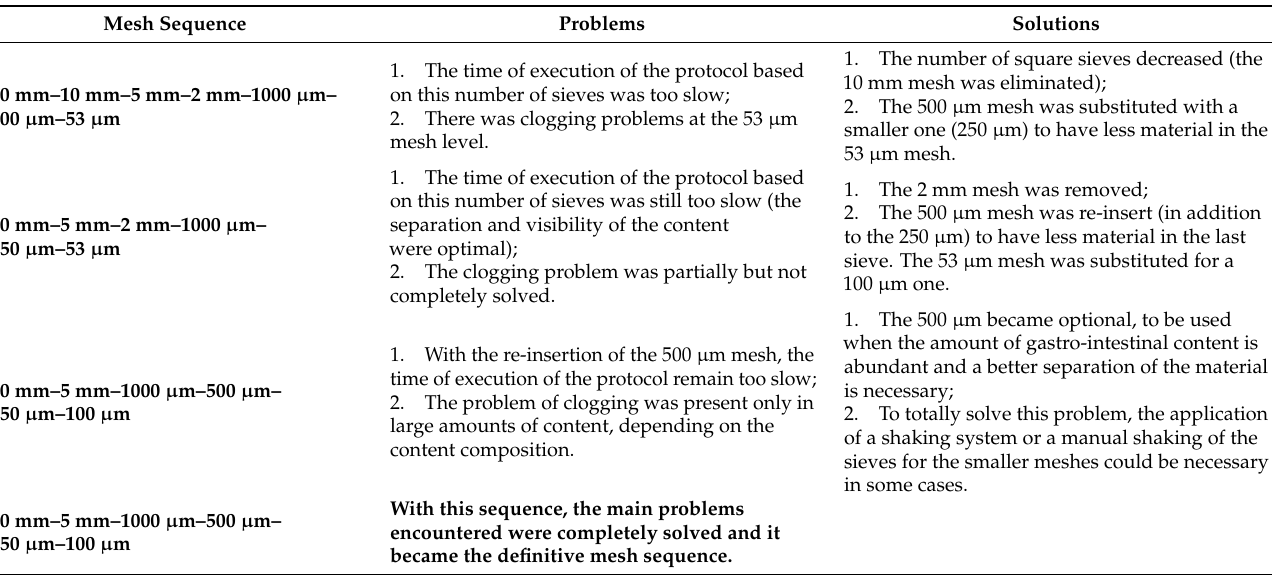
Table 3. Meshes size selection process. Mesh sequences tested during the practical sessions, problems encountered and respective solutions. Mesh